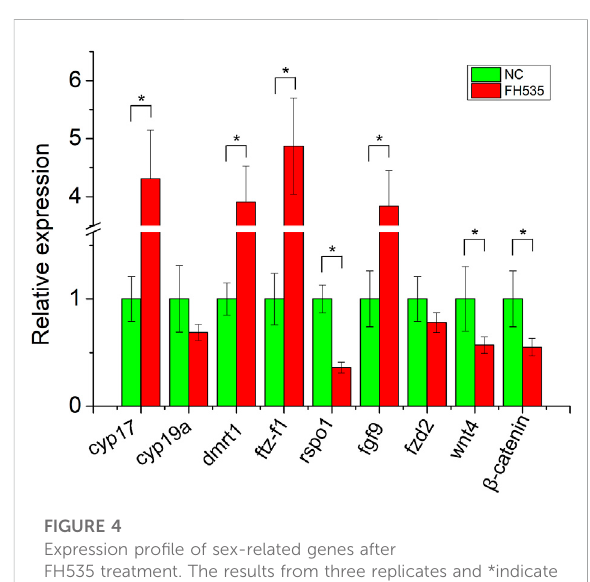
FIGURE 4 Expression pro fi le of sex-related genes after FH535 treatment. The results from three replicates and *indicate the signi fi cantly difference ( p <